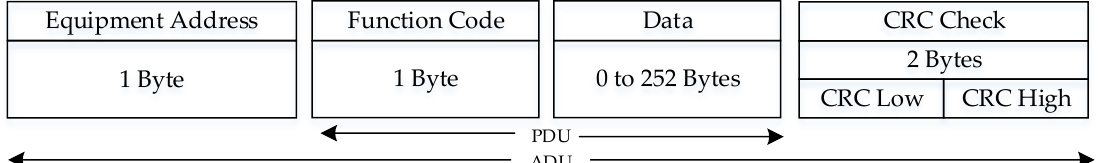
Figure 1. The frame structure of the Modbus RTU in the data link layer.